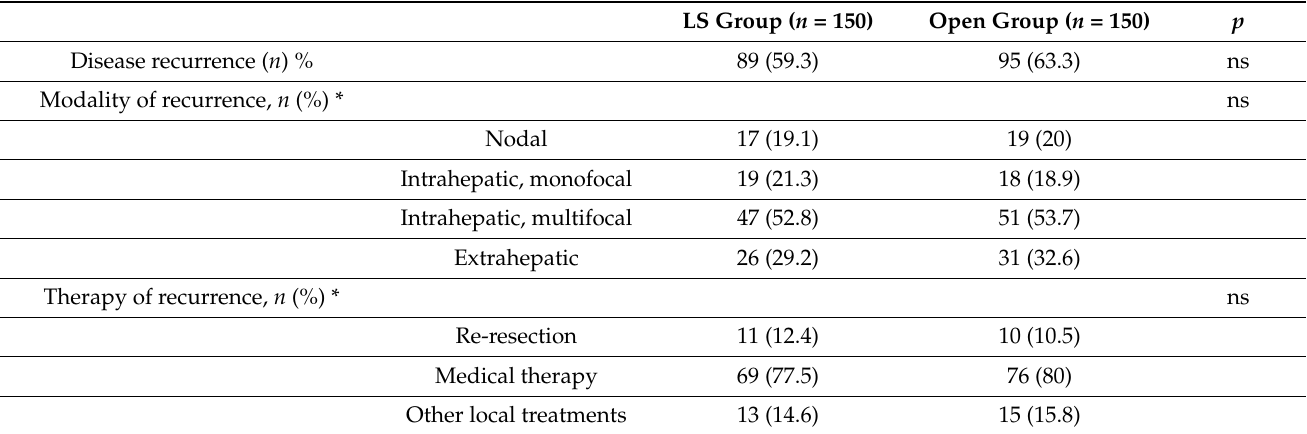
Figure 2. Survival functions. ( a ) Disease free survival according to treatment group (open versus laparoscopic). ( b ) Overall survival according to treatment group (open versus laparoscopic). Table 3. Long-term